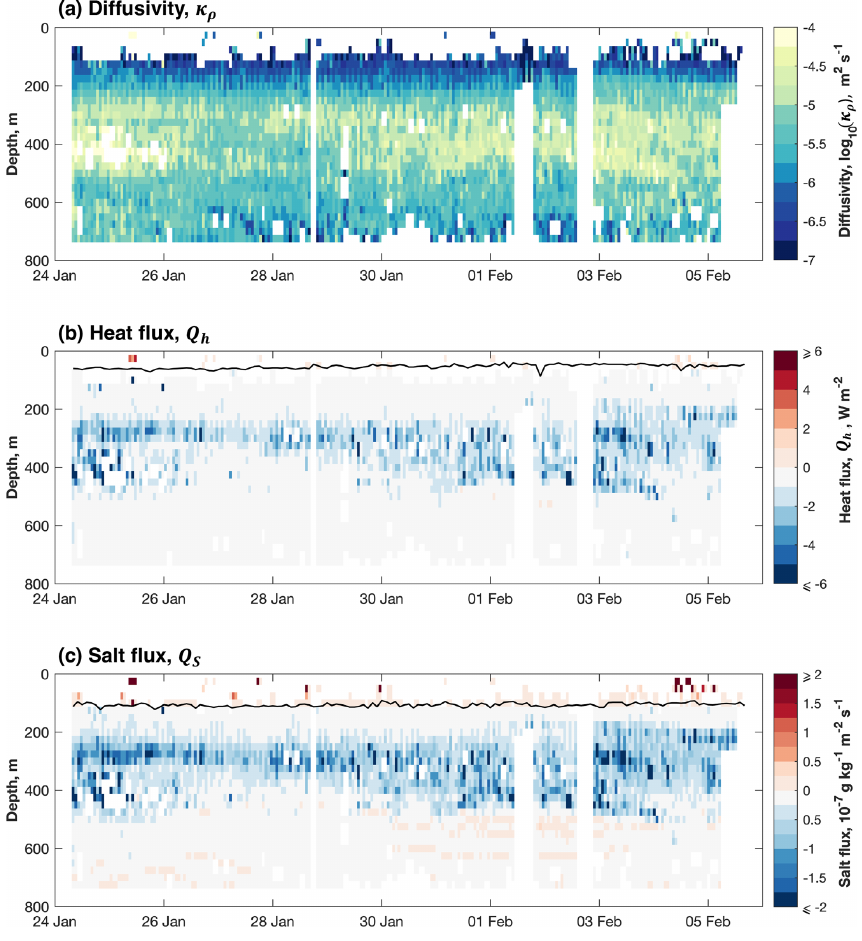
Figure 7. (a) Diffusivity, log 10 ( κ ρ ) (m 2 s − 1 ). (b) Vertical heat flux, Q h (Wm − 2 ). (c) Vertical salt flux, Q S (10 − 7 gkg − 1 m − 2 s − 1 ). Negative fluxes are downward. All are calculated from ε using the Batchelor spectrum method. The black lines in (b) and (c) indicate the depth of, respectively, the temperature and salinity maxima, as derived from 1m binned Seaglider